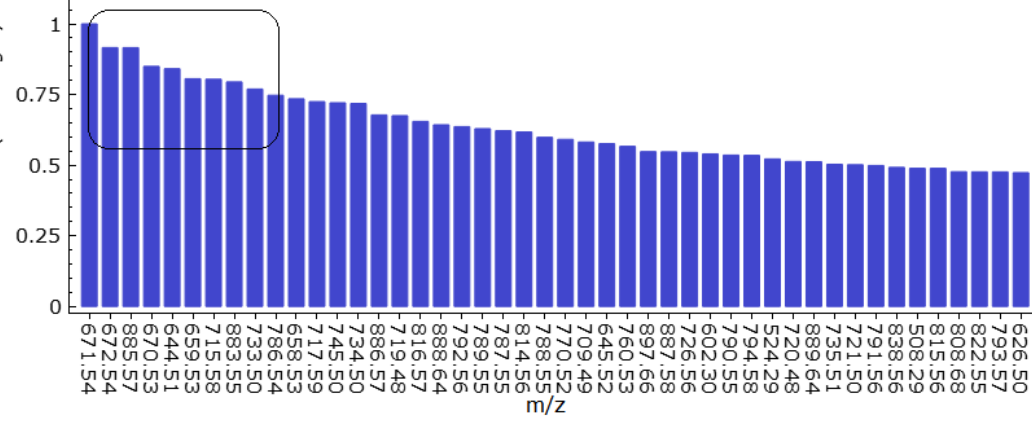
Figure 8. Bar chart visualization of decreasing dimension axis lengths of Figure 7 allows for easy selection of dimensions with highest weight, which represent most discriminant peaks for cluster separation in Figure